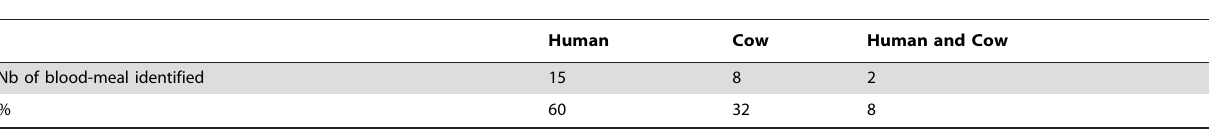
Table 4. Blood meal identifications from Ae. j. japonicas .